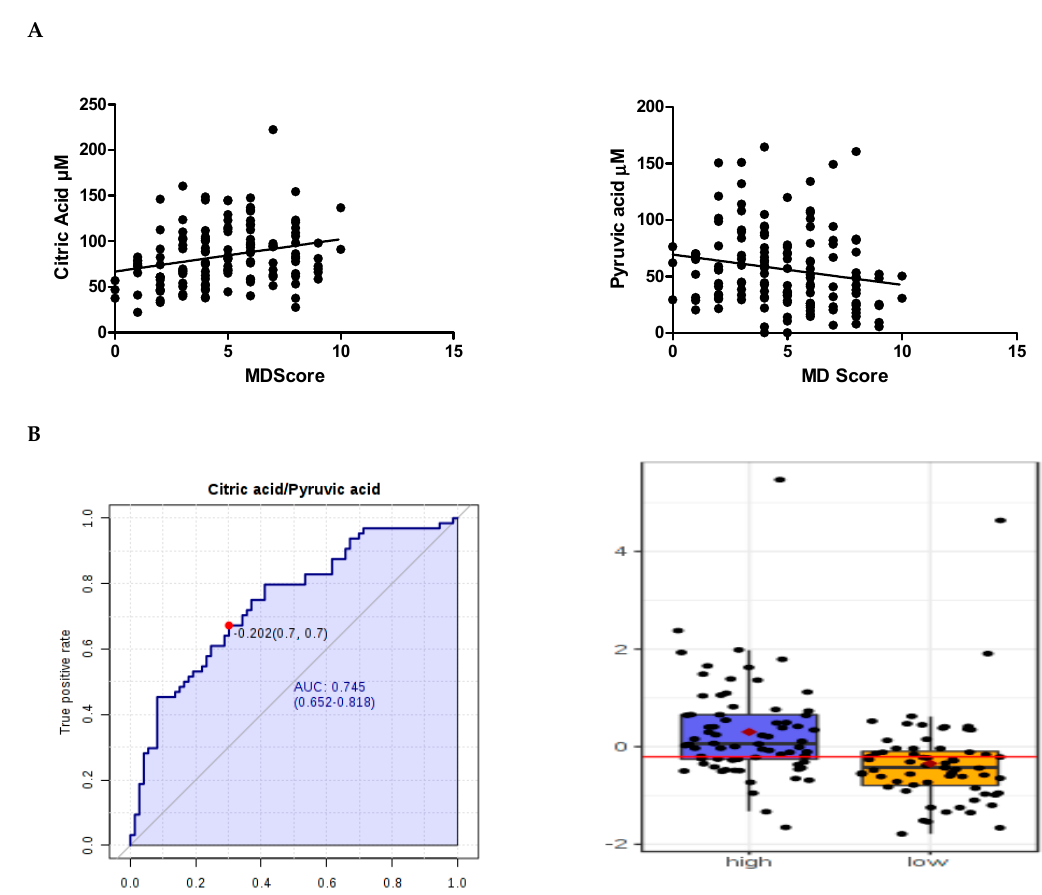
Figure 2. Blood levels of citric acid and pyruvic acid and MDS. ( A ) Citric acid levels positively correlated with MDS, whereas Pyruvic acid levels negatively correlated. ( B ) A paired metabolite ratio of citric acid and pyruvic acid achieved the greatest area under the receiver operating characteristic (ROC) curve (AUC = 0.74) value which was the best performing biomarker for MDS. Optimal cutoff was represented on the curve with a red dot and with a red horizontal line on the box plot. The box-plot showed that the overall distribution profiles for low MDS (0–4) and high MDS (5–10) were broadly similar but the mean value was 53% higher in the high MDS group. Y-axis represents concentrations ( µM ). Data were median centred. The mean concentration of each group was indicated with a red diamond.